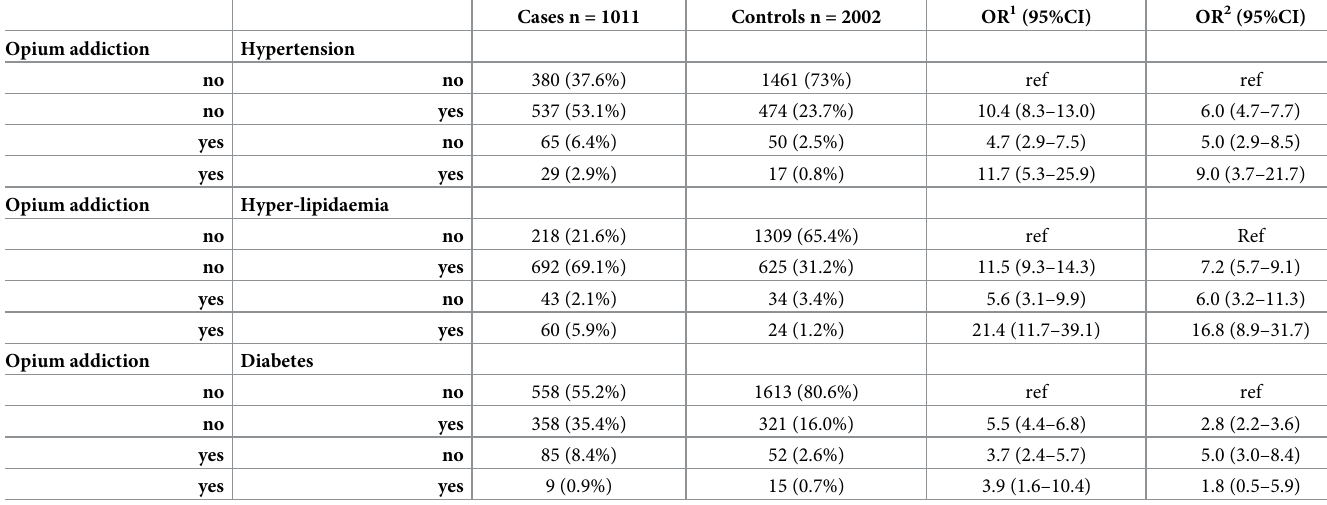
Table 3. Risk of CAD in relation to the combination of opium addiction and the presence of the major cardiovascular risk factors.